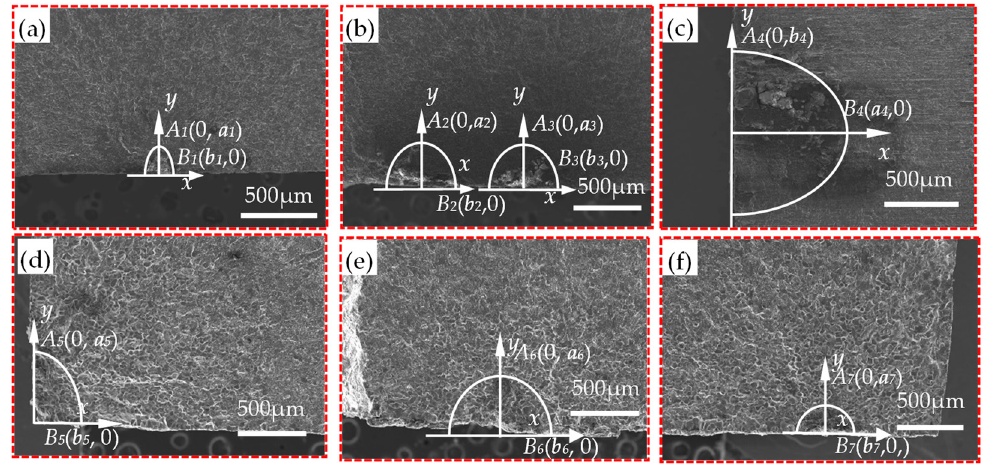
Figure 11. Schematic representation of the equivalent semi-elliptic crack.